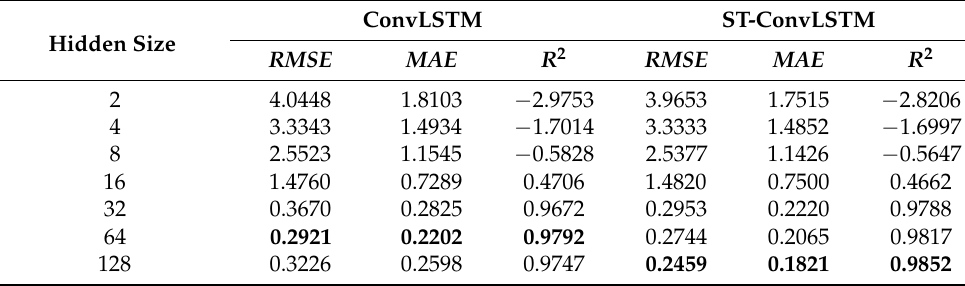
Table 5. Effect of hidden size on SST